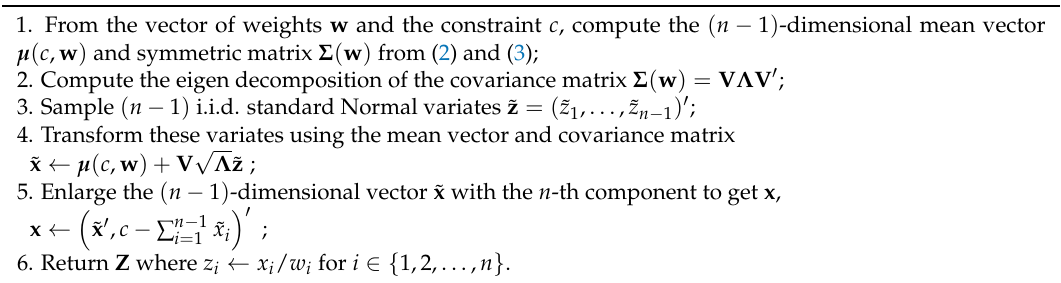
Algorithm 1. Sampling of Z given w (cid:48) Z = c .